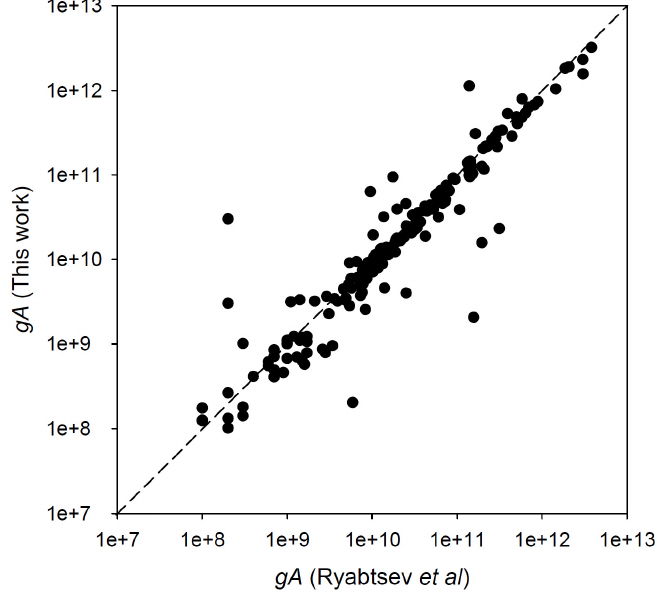
Figure 3. Comparison between the transition probabilities ( gA in s − 1 ) computed in the present work and those obtained by Ryabtsev et al. [13] for experimentally identified spectral lines in W